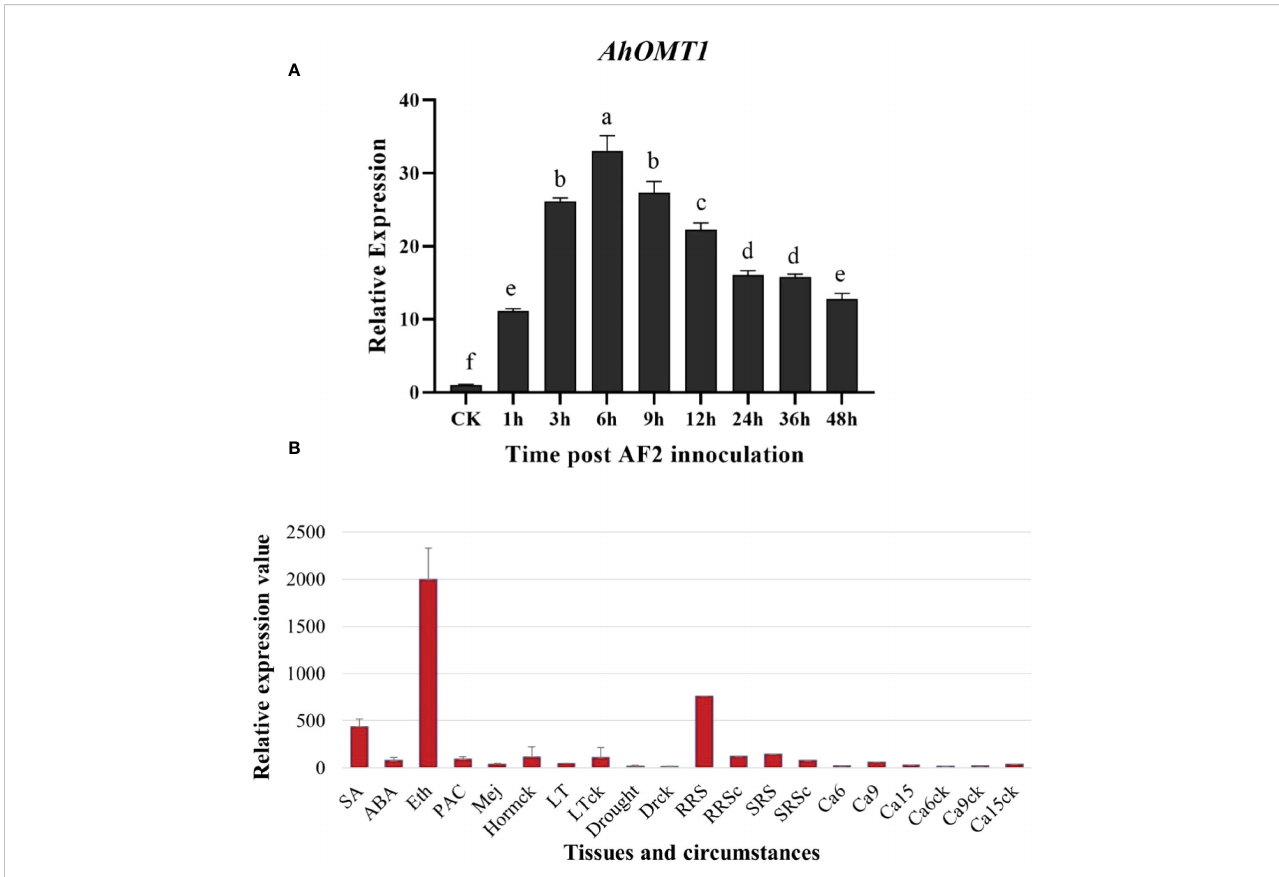
FIGURE 2 Characteristics of AhOMT1 expression in peanut. (A) Expression analysis of AhOMT1 gene in response to A. fl avus infection determined by qRT-PCR. AhOMT1 showed high level of expression upregulation upon A. fl avus infection in peanut leaves. Expression was increased after one hour of inoculation that showed increasing trend upto 6 hours. After 6 hours, expression showed a decreased trend but still was very high as compared to non-treated leaves. (B) AhOMT1 gene demonstrated little responses to hormones and environmental stresses besides Ethephon treatment (Eth) with upregulation. SA, salicylic acid; ABA, abscisic acid; PAC, paclobutrazol; Mej, Methyl jasmonate; LT, low temperature; RRS, Ralstonia solanacearum inoculation on resistance peanut; RRSc, resistance cultivar without inoculation; SRS, R. solanacearum inoculated on susceptible cultivar. SRSc, susceptible cultivar without inoculation; Ca6/9/15: embryo in de fi cient calcium at 6, 9 and 15 days after pegging; Ca6/9/15ck: embryos in suf fi cient calcium at 6, 9 and 15 days after